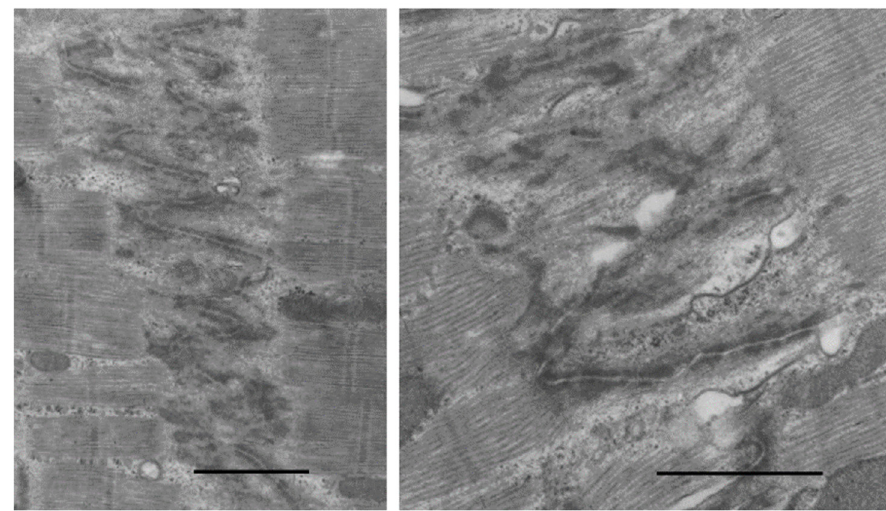
Figure 10. Electron micrographs of expanded ICD in dogs with progressive pressure overload LVH and failure from aortic banding as puppies. Increased folding of ICD has actin and myosin within folds forming new sarcomeres. Bar = 2 µm in each.